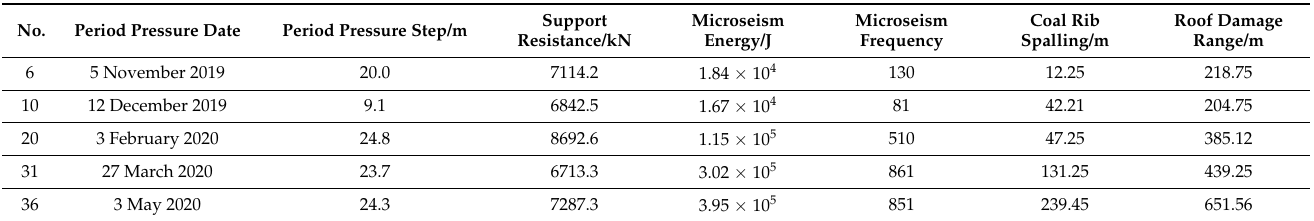
Figure 3. Roof damage and coal rib spalling distribution map (the blue number 1–8 is the serial number of the roof damage area, and the red number 1–10 is the serial number of the concentration areas of coal rib spalling). Table 1. Critical information of five representative